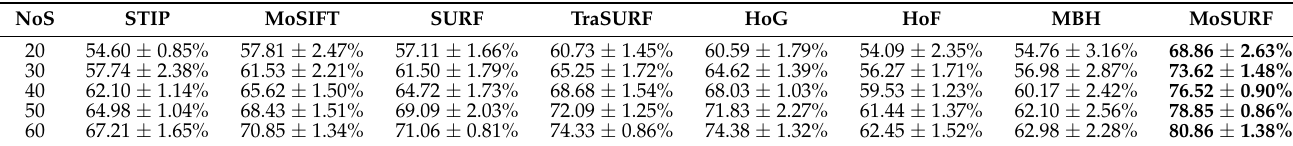
Table 2. Experimental results for different descriptors on YouTube.